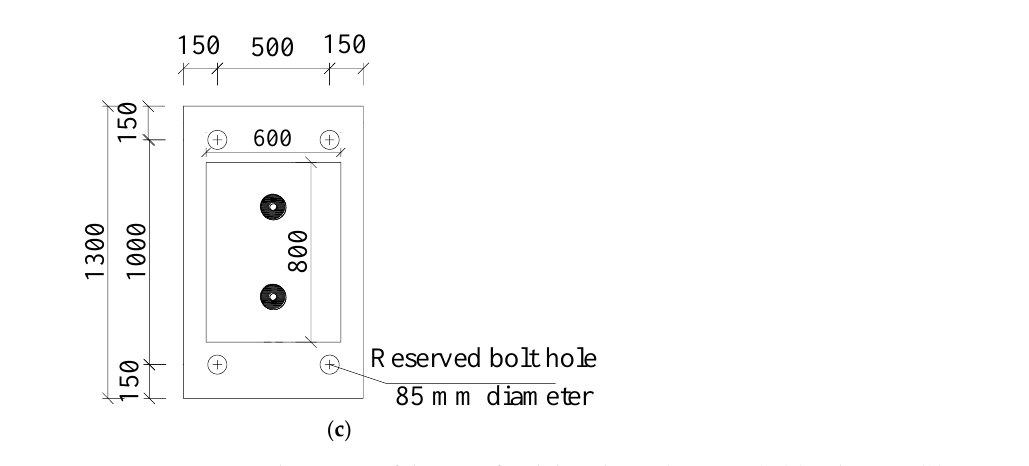
Figure 3. Specimen dimension of the semi-fixed dowel joint (unit: mm). ( a ) Side view. ( b ) Front view. ( c ) Top view.